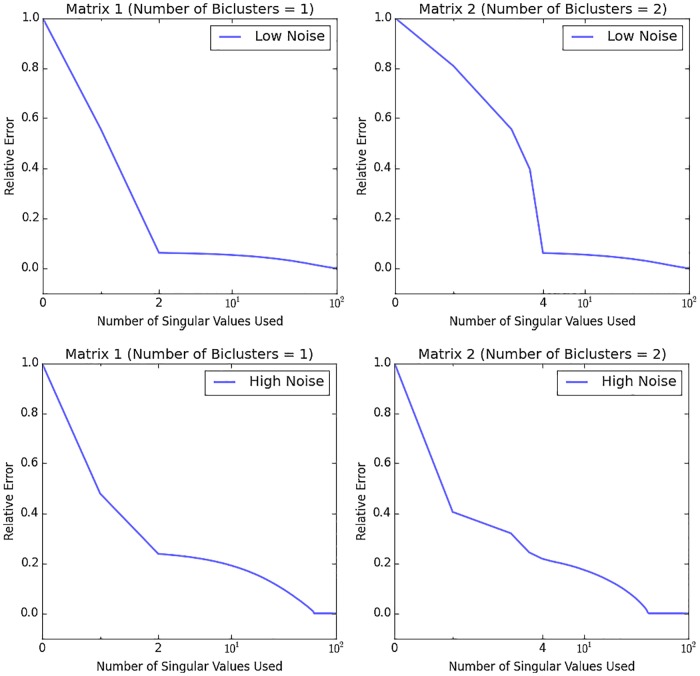
Derivation of the optimal rank.According to the relative error curve with different number of singular values used, the optimal rank of the Matrix 1 and Matrix 2 are 2 and 4, respectively.